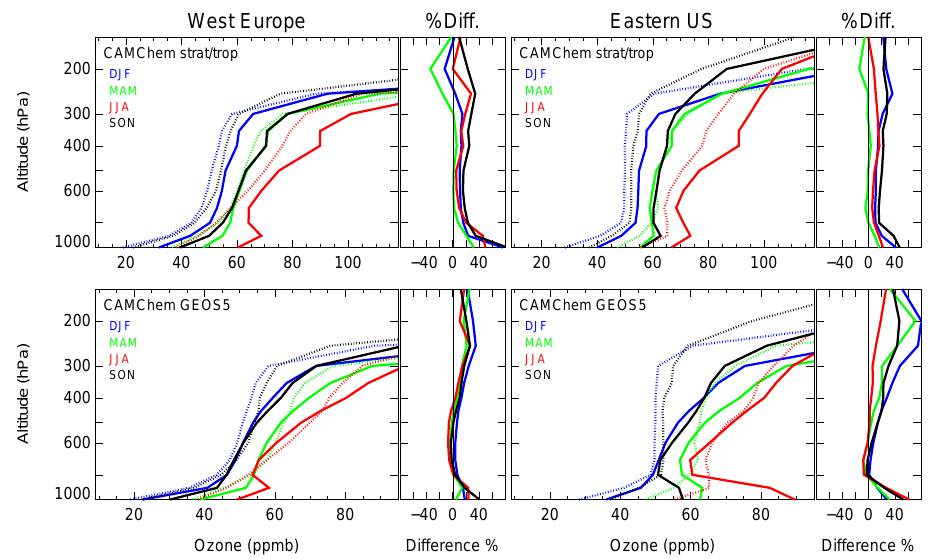
Fig. 13. Regionally aggregated ozone profiles from model simulations (solid lines) and from the ozone climatology (dotted lines) for different seasons (colors) over Western Europe (left) and Eastern US (right). Results from CAMChem strat/trop are shown in the first row, CAMChem GEOS5 results are shown in the second row. Different colors indicate different seasons. The relative differences between observed and simulated ozone are shown on the right of each panel.